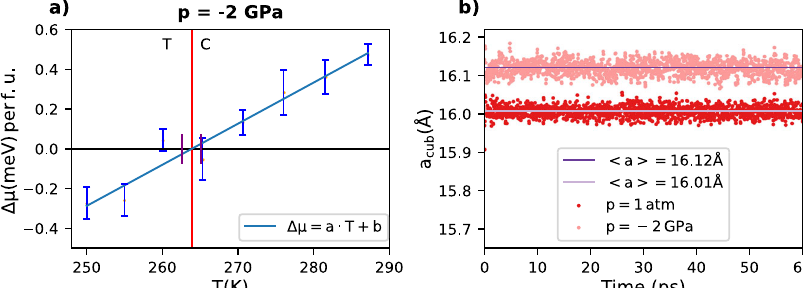
Fig. 9 Results of the MD simulations with an externally applied negative pressure p = − 2 GPa. Panel a shows the chemical potential differences across the T-C transition, obtained via NST fully fl exible simulations and with an estimated Curie temperature of T c = (264 ± 1) K, as opposed to (182.4 ± 0.7) K calculated at ambient pressure (see subsection “ Thermodynamics of BaTiO 3 ” ). Panel b shows instead a comparison between the time evolution of the lattice constant in NpT simulations at 250 K with negative pressure and ambient pressure. These show how the effect of a negative pressure slightly increases the average unit-cell lattice parameter (by only 0.7%) due to the large bulk modulus of BaTiO 3 . This has, however, important consequences on the relative stability of T and C phases, with a shift of the Curie point of 82 K with respect to the ambient pressure estimate. Error bars have the same meaning as in Fig.